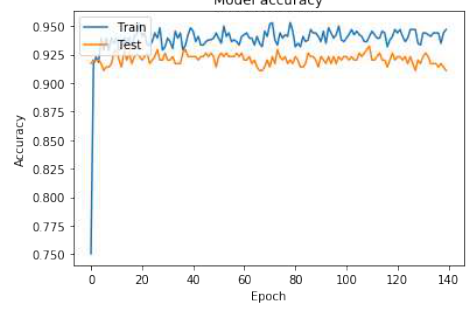
Figure 8. Epoch vs. Accuracy